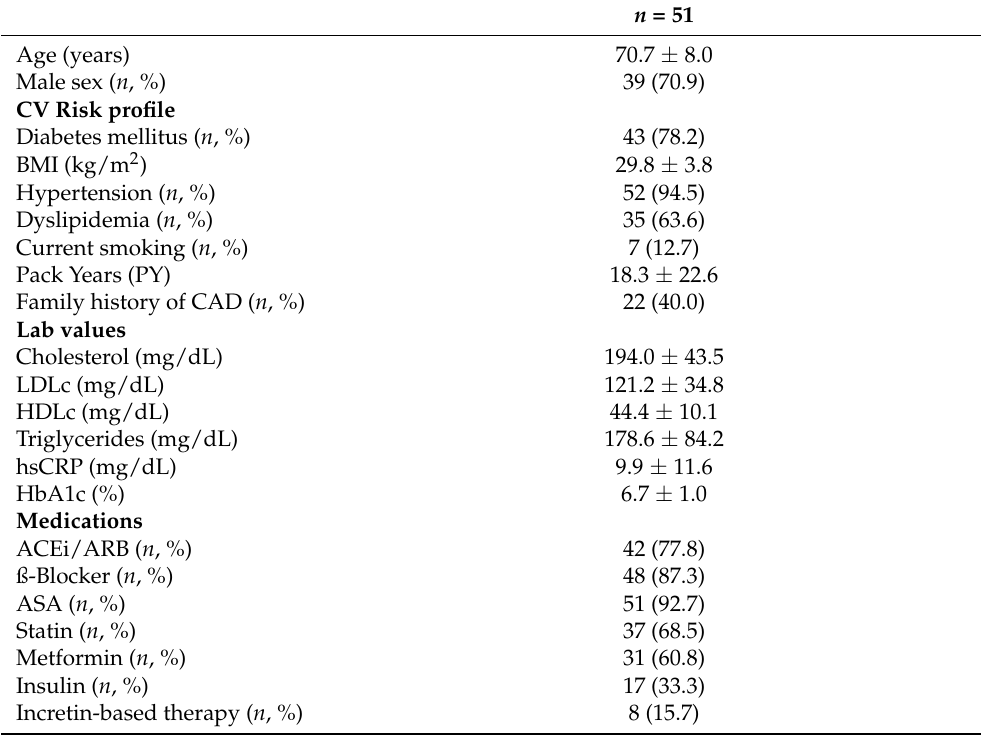
Table 1. Patient characteristics. Abbreviations: BMI = Body Mass Index, CAD = Coronary artery disease, ACEi = angiotensin-converting enzyme inhibitor, ARB = Angiotensin II receptor blockers, ASA = acetylsalicylic acid.